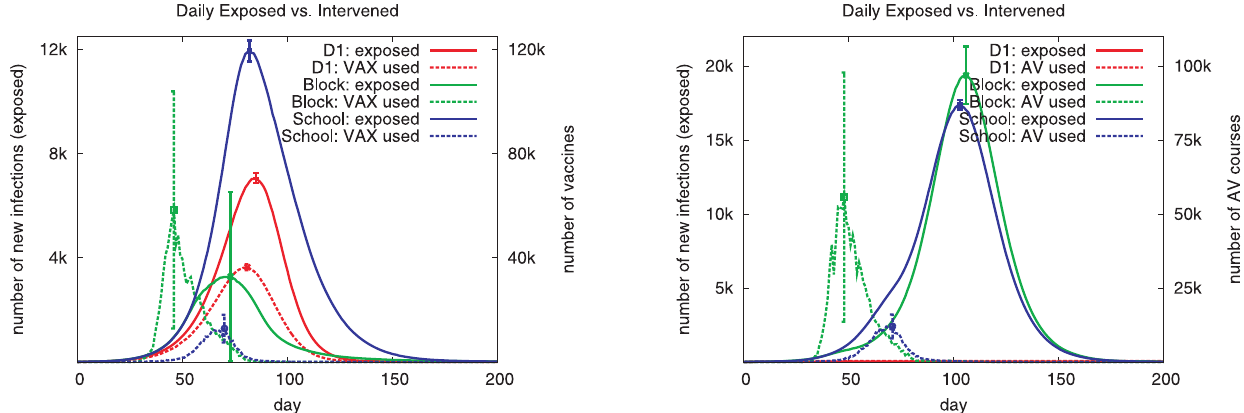
Figure 1. Number of people exposed versus the amount of vaccine and antiviral used under each of the three strategies considered. On the left, number exposed versus the number of vaccines used on a daily basis; on the right, the number exposed versus the courses of antivirals used on a daily basis. Error bars at the peak of each curve show the standard deviation over 25 runs of the stochastic simulation and are indicative of the level of error over the rest of the curve. D1 refers to the bottom-up strategy, and Block and School refer to the top-down strategies. The parameters settings used here include high transmissibility i.e. 40% infection attack rate, diagnosis probability of 1, threshold value of 0.01, and the compliance probability of 0.5.